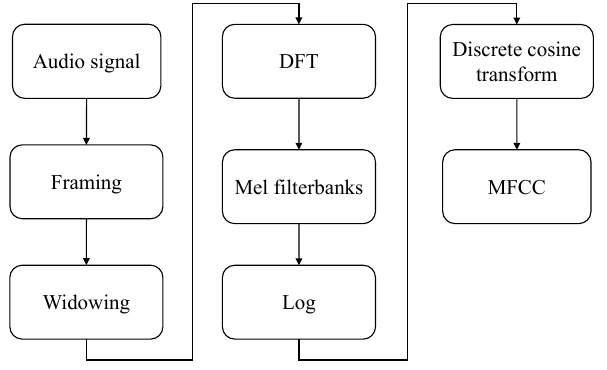
Figure 10. MFCC feature extraction process.